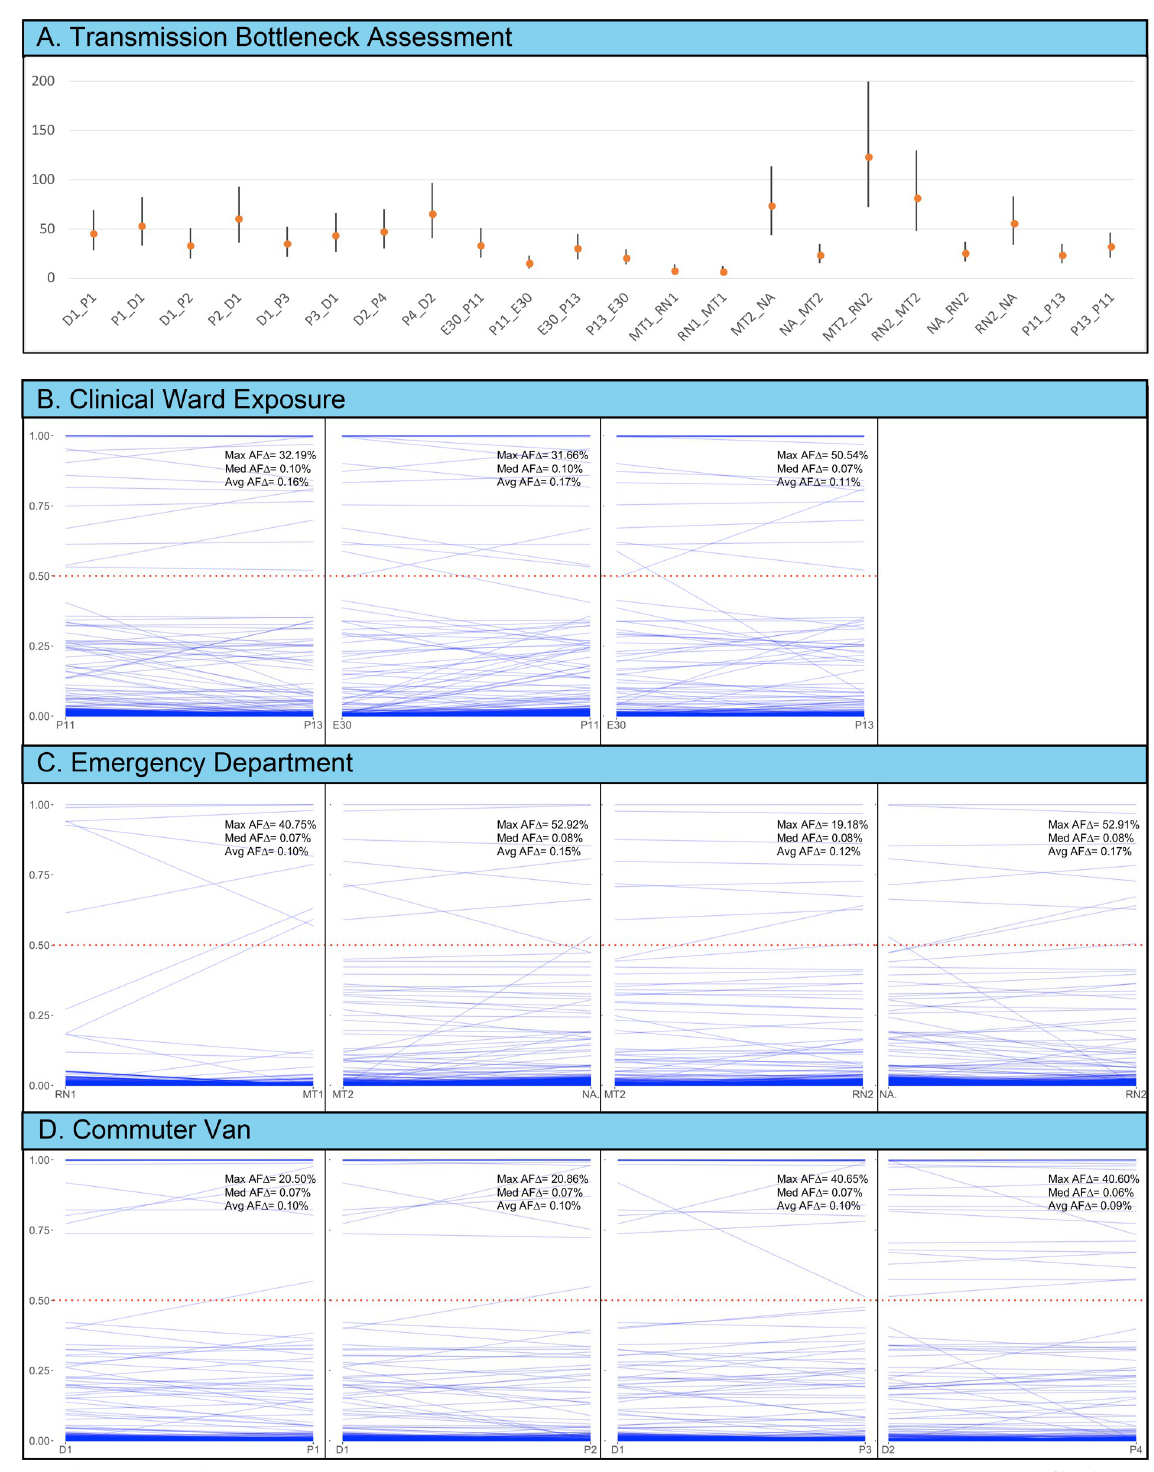
Fig 5. (following page). SARS-CoV-2 Transmission Bottleneck Assessment and Infection Sequence Complexity. a Summary of bottleneck evaluations for 11 donor-recipient pairs. Dates of transmission include June/July 2020 –MT1-RN1, MT2-RN2, NA-MT2, NA-RN2; November 2020/January 2021 – P11-P13, P11-E30, P13-E30; December 3, 2020 –D-P1, D1-P2, D1-P3; January 23, 2021 – D2-P4. Individual results provide the mean predicted number of virions for each transmission event and 95% CI. b-d Transmission graphs showing AAFs between the 11 infected donor and exposed recipient pairs. Infection complexity is demonstrated by an array of AAFs from 0.05 to 1.0